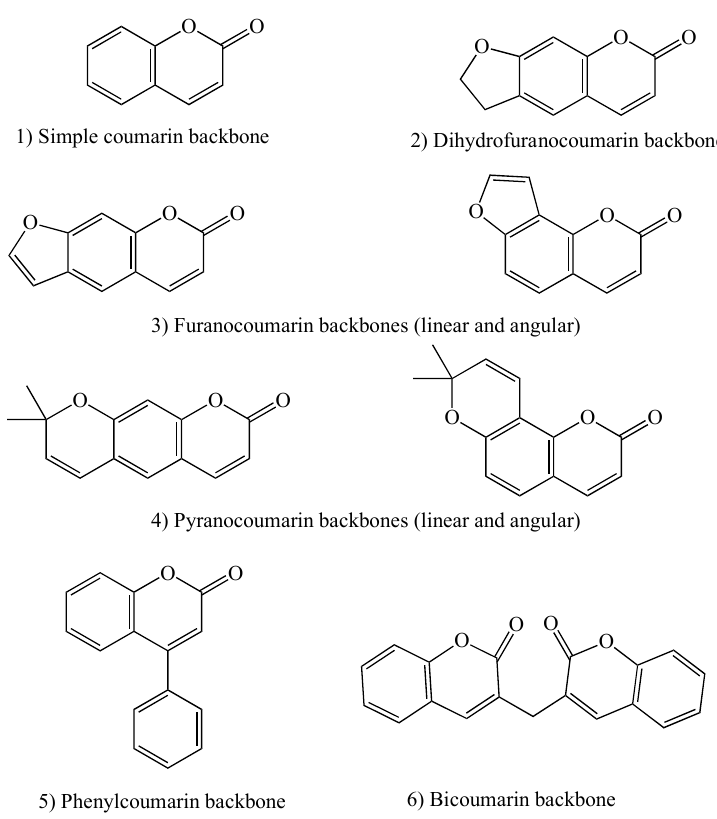
Figure 2. Types of coumarin backbone structures.